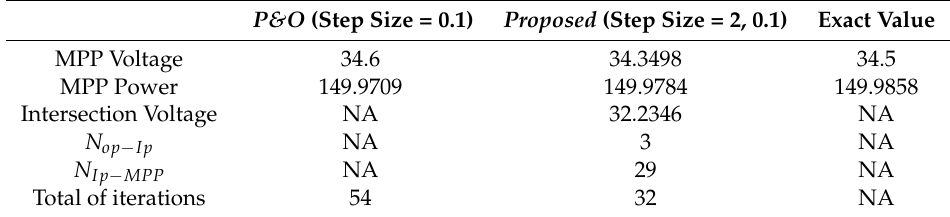
Table 3. No. of iterations comparison between developed and P&O when the operating point lies at right of